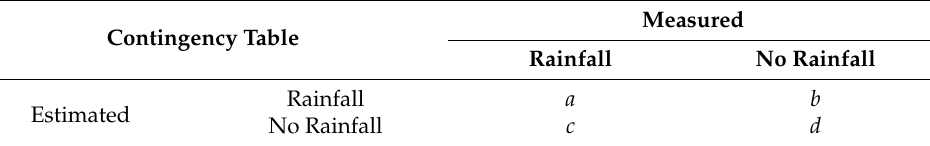
Table 3. Contingency table to assess the accuracy of the daily GLDAS, MERRA, TRMM, and GPM products in the state of Mato Grosso, Brazil. The table was not applied to GPCP since it does not provide estimates of daily